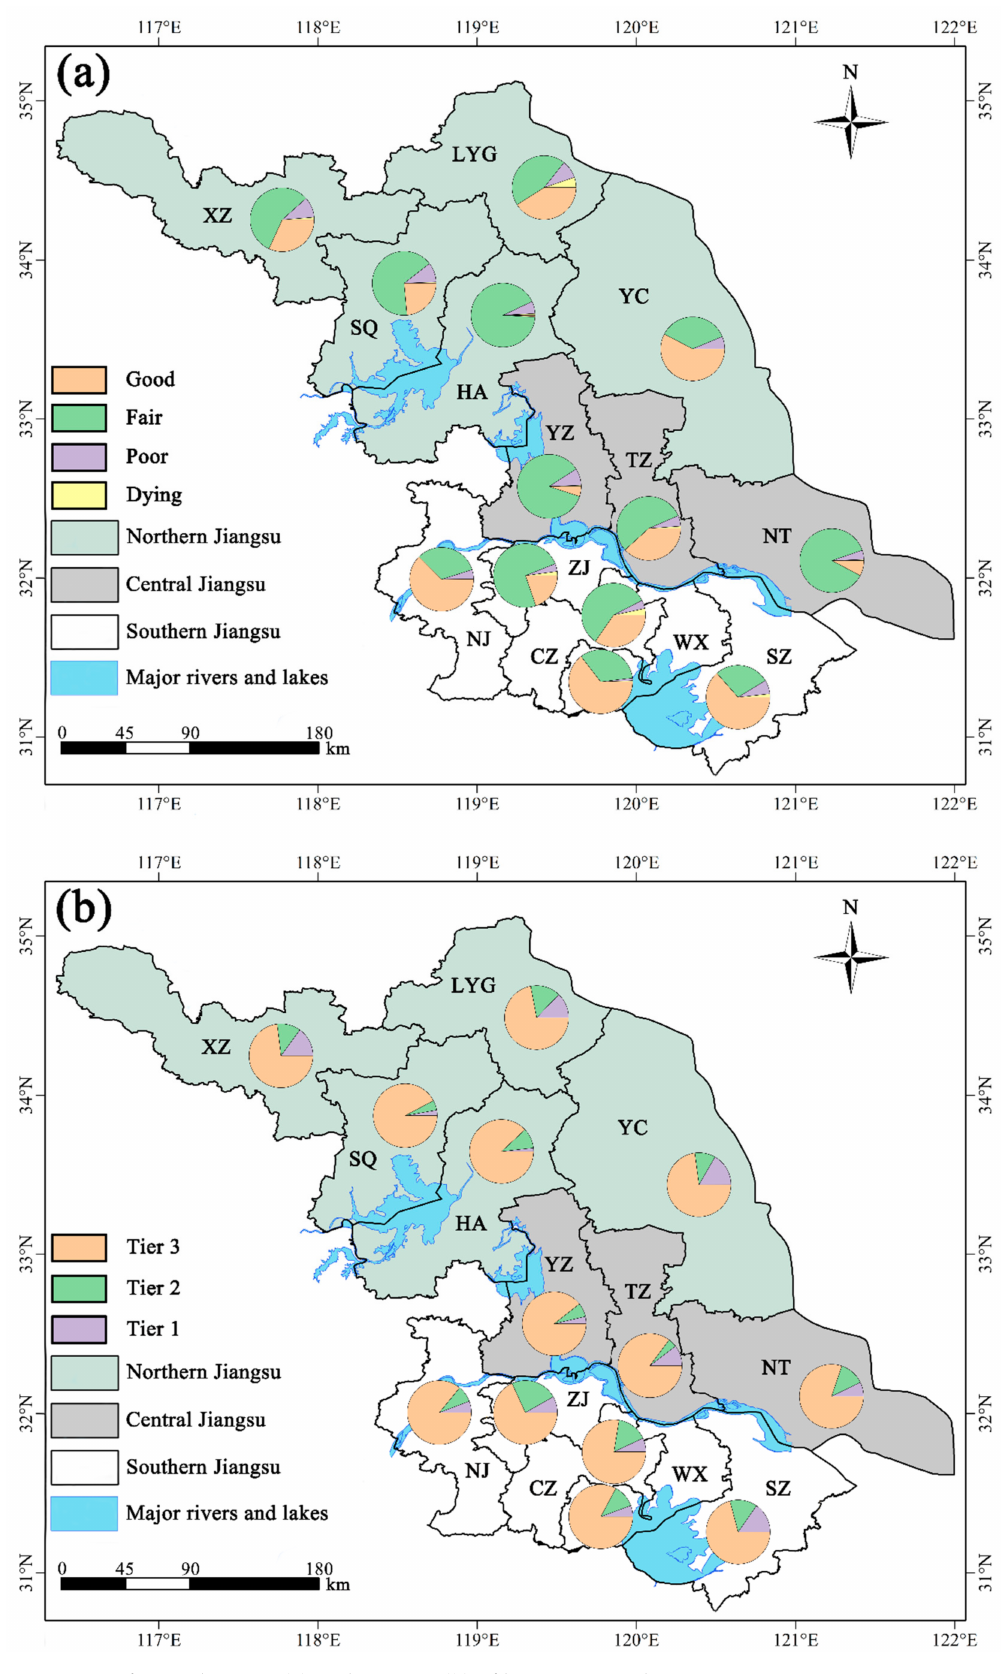
Figure 6. Proportion of growth status ( a ) and tree age ( b ) of heritage trees by 13 cities in Jiangsu Province, eastern China. Refer to Table 1 for the meaning of the abbreviated